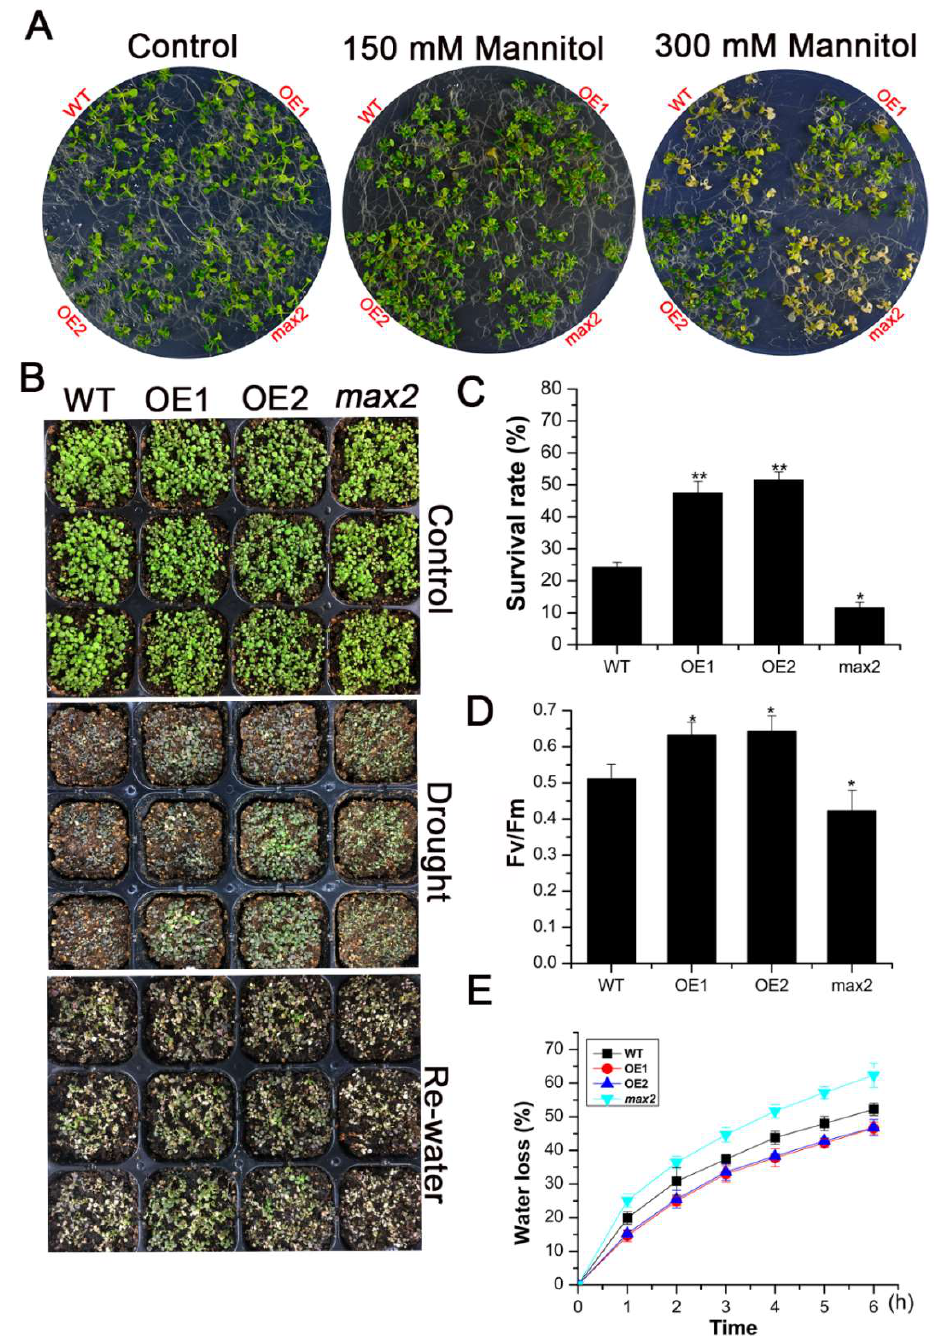
Figure 3. Constitutive expression of SsMAX2 promoted osmotic and drought stress resistance in Arabidopsis . ( A ) Phenotype of SsMAX2 OE lines, max2 , and wild-type (WT) in half MS medium containing 150 and 300 mM mannitol; ( B ) Phenotype of different Arabidopsis lines after withholding water and rewatering treatment; ( C ) Survival rate of seedlings after drought treatment; ( D ) Maximum photochemical efficiency of PSII (Fv/Fm) of different lines under drought stress; ( E ) Water loss rate. Data are presented as means ± SD of three biological replicates. Significant differences were determined by Student’s t -test. Significance level: * p < 0.05, ** p < 0.01.